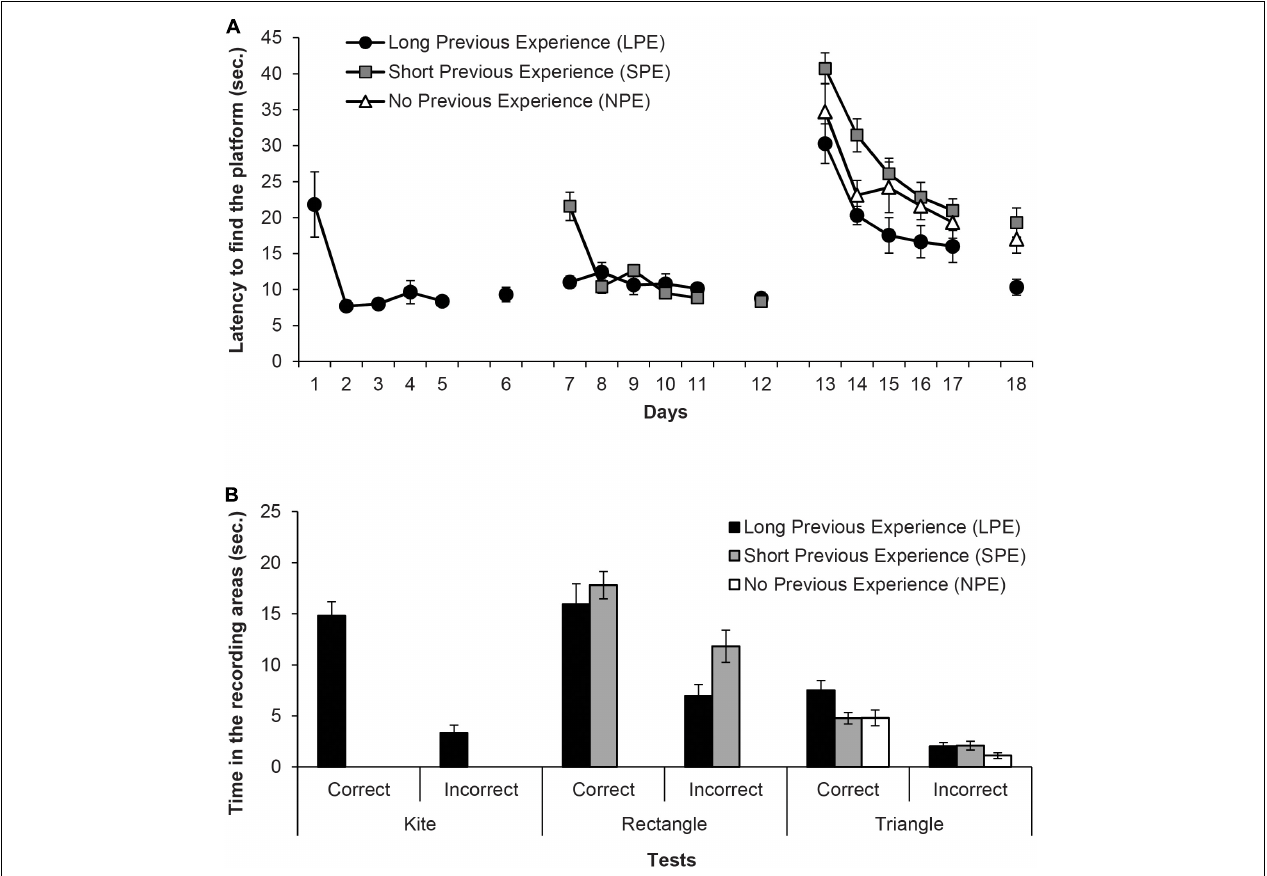
FIGURE 2 | (A) Mean escape latencies by the subjects in Experiment 1 during the three training phases and the escape trials of the test days. Error bars denote standard error of the mean. (B) Mean time spent by the subjects in Experiment 1 in the two recording areas (correct and incorrect) during the Kite test trial (Group LPE), Rectangle test trial (Groups LPE and SPE) and in the final Triangle test trial (Groups LPE, SPE, and NPE). Error bars denote standard error of